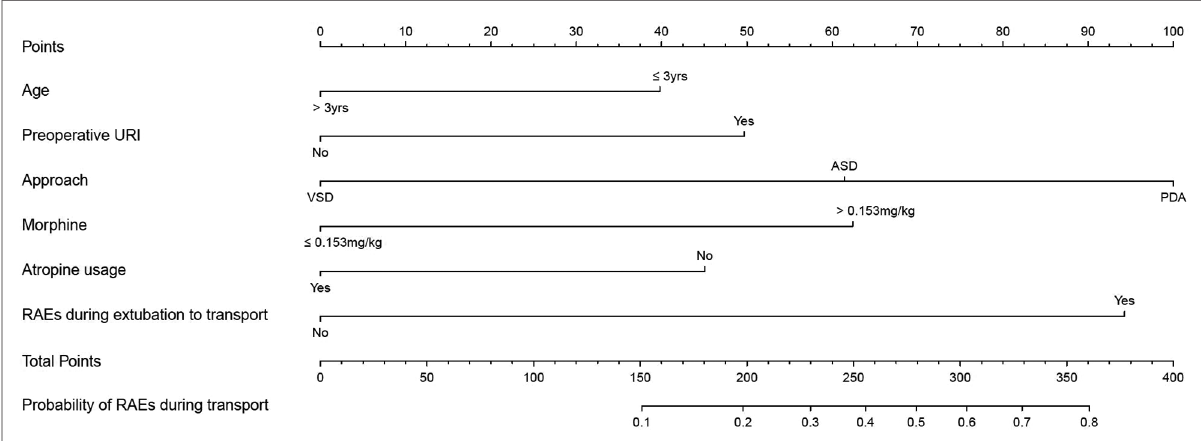
FIGURE 3 A novel nomogram to predict RAEs during transport. The nomogram provides a visual point system based on the combination of patient characteristics (age, preoperative URI, type of surgery, morphine equivalent, atropine usage, and RAEs during extubation to transport) to estimate the probability of RAEs during transport. To calculate the probability of RAEs during transport, the points of six variables determined on the scale were added to obtain the total points. Draw a vertical line from the total points scale to the last axis to obtain the corresponding probability of RAEs during transport. For example, if a pediatric patient ≤ 3 years (40 scores), combined with preoperative URIs (50 scores), presenting for ASD (60 scores), accompanied with morphine equivalent >0.153 mg/kg (60 scores) and atropine usage (45 scores), and developed RAEs during extubation to transport (95 scores), the total points were 350 scores, and the corresponding occurrence of RAEs during transport were nearly 80%. URI, upper respiratory tract infection; ASD, atrial septal defects; VSD, ventricular septal defects; PDA, patent ductus arteriosus; RAEs, respiratory adverse